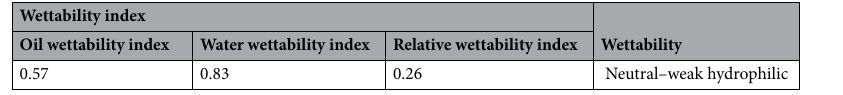
Table 1. Results of wettability experiment from 18 core samples.